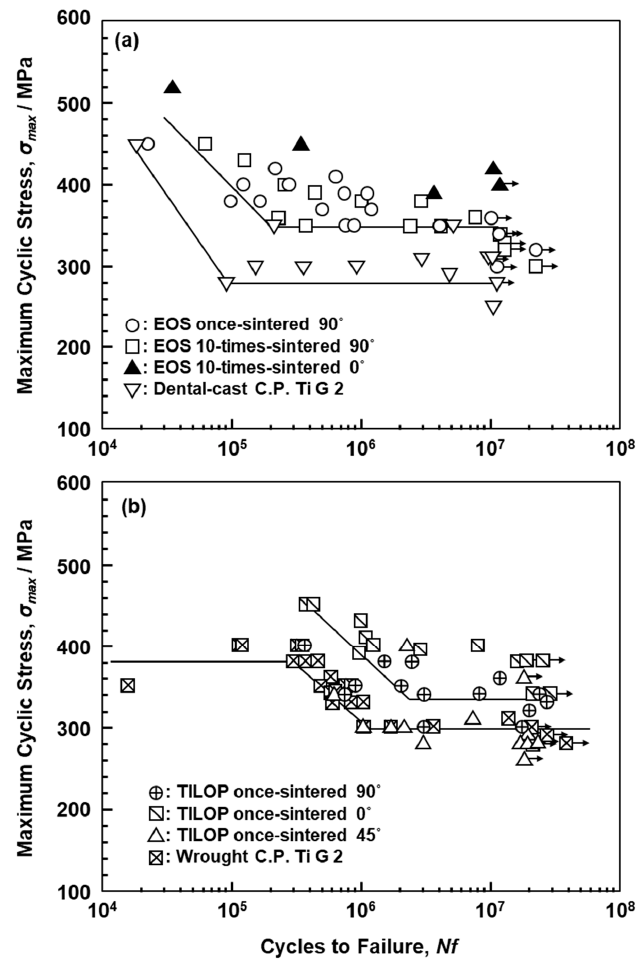
Figure 10. S–N curves of laser-sintered ( a ) EOS (once- and 10-times-sintered) and ( b ) TILOP (once-sintered) CP Ti G 2 rods; dental-cast CP Ti G 2 in ( a ) and wrought CP Ti G 2 in ( b ). Materials 2020 , 12 , x FOR PEER REVIEW